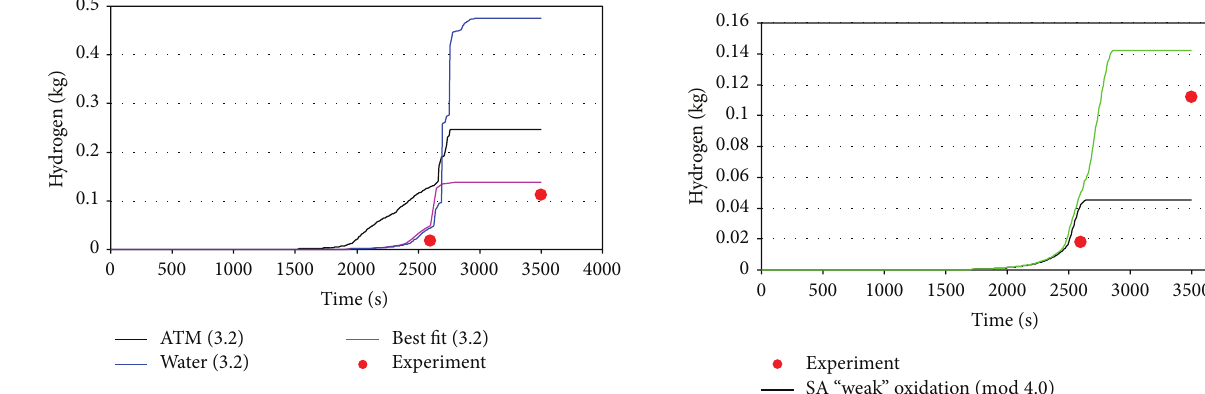
Figure 9: QUENCH-03 test calculation using RELAP/SCDAPSIM mod 3.2. The first approach of heat generation in “Cora” description. Total hydrogen mass of QUENCH-03 experiment.